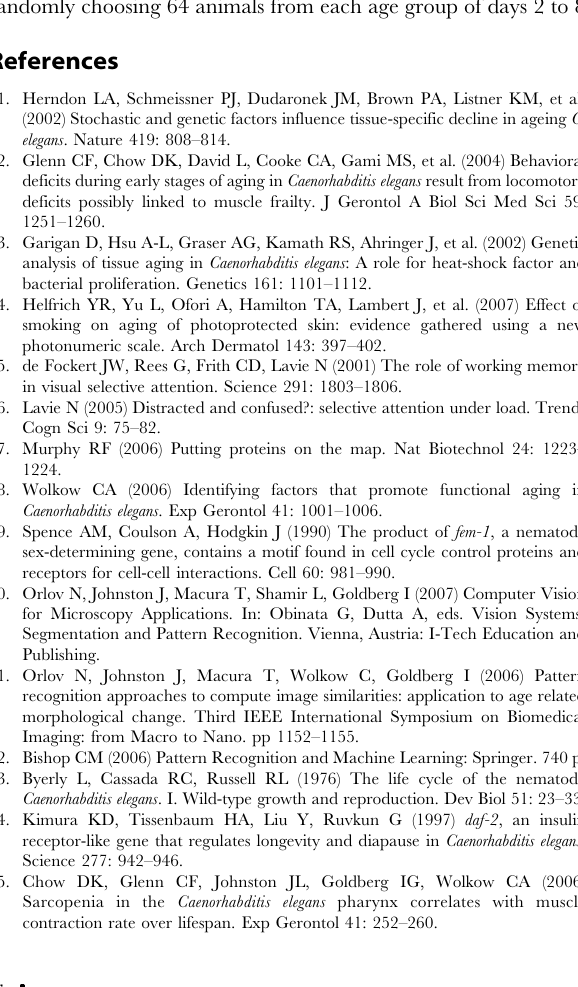
Figure S1 Binary classification of pharynx images from daf- 2(e1368) or (e1370) at day 15 and 20. Found at: doi:10.1371/journal.pone.0002821.s001 (1.98 MB TIF) Figure S2 Survival of imaged and untreated (control) popula-